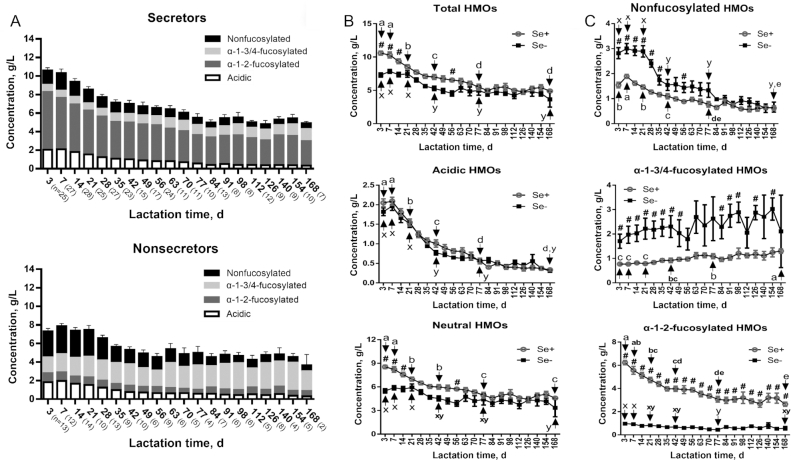
Concentration changes of HMOs in milk of Se+ and Se− mothers during lactation. (A) Overview of HMO subtype changes in Se+ and Se− mothers during lactation. Acidic HMOs are calculated as LSTc + 6′-sialyllactose + 3′-sialyllactose + LSTa + LSTb + disialyllacto-N-tetraose + disialyl lactose. Nonfucosylated HMOs are calculated as lacto-N-triose + lacto-N-neotetraose + p-lacto-N-neohexaose + lacto-N-neohexaose + lacto-N-tetraose + lacto-N-neooctaose. α-1-2-fucosylated HMOs are calculated as LNDFH I + Blood Group A tetrasaccharide + lactodifucotetraose + 2′-FL + LNFP I. α-1-3/4-fucosylated HMOs are calculated as lacto-N-neodifucohexaose + LNDFH II + difucosyllacto-N-hexaose + 3-fucosyllactose + LNFP II + lacto-N-neofucopentaose + LNFP V. Comparison of dynamic changes of (B) HMO concentrations and (C) neutral HMO subtypes in Se+ and Se− mothers during lactation. All values are means ± SEMs. “a”, “b”, … and “x”, “y” … indicate differences among different time points in Se+ and Se− mothers, respectively. # indicates statistical significance between Se+ and Se− mothers at the same lactation time. P < 0.05 was considered significant. HMO, human milk oligosaccharide; LNDFH, lacto-N-difucohexaose; LNFP, lacto-N-fucopentaose; LST, LS-tetrasaccharide; Se+, secretor; Se−, nonsecretor.